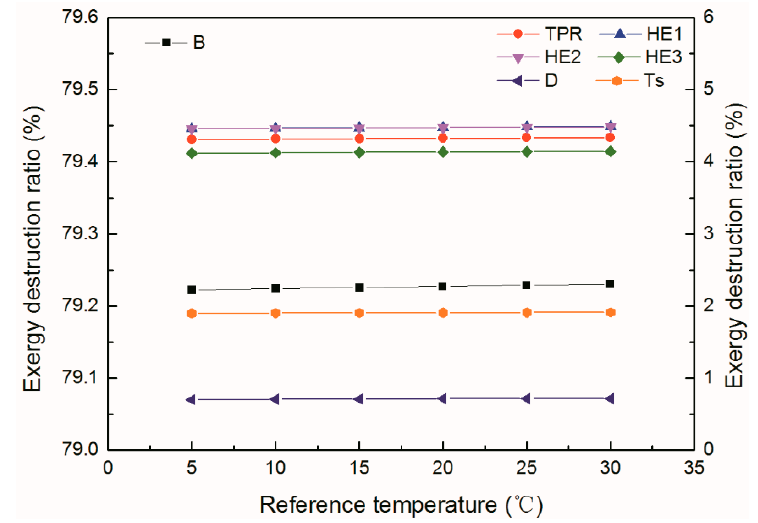
Figure 9. Effect of reference temperature on exergy destruction of major components.